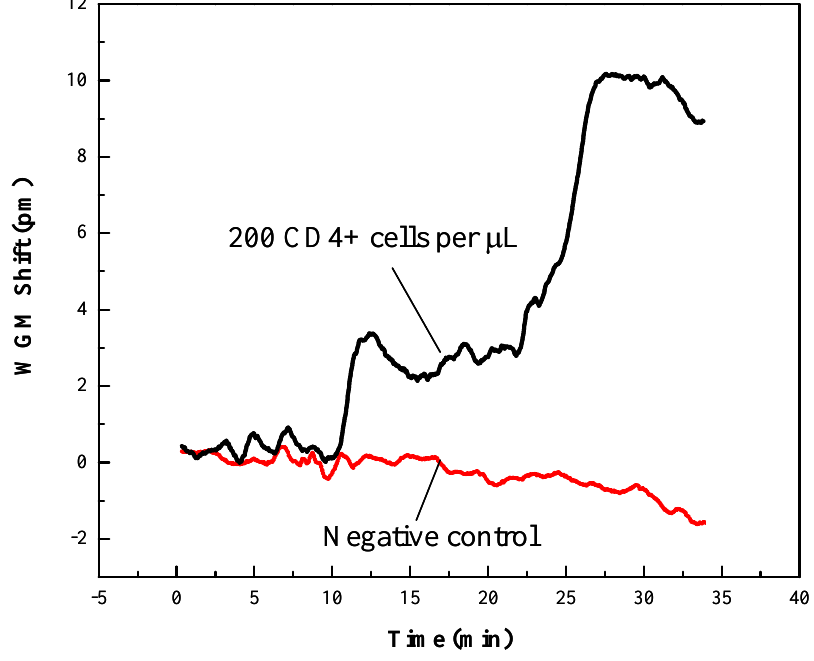
Figure 2. Sensorgram trace of a positive control sample containing approximately 200 CD4+ cells per µL. Negative control consists of diluted serum and red blood cells.